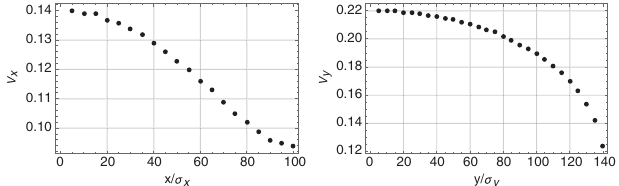
FIG. 7. Horizontal tune dependence on initial horizontal coordinate (left) and vertical tune dependence on initial vertical coordinate (right), the remaining initial coordinates are zero.